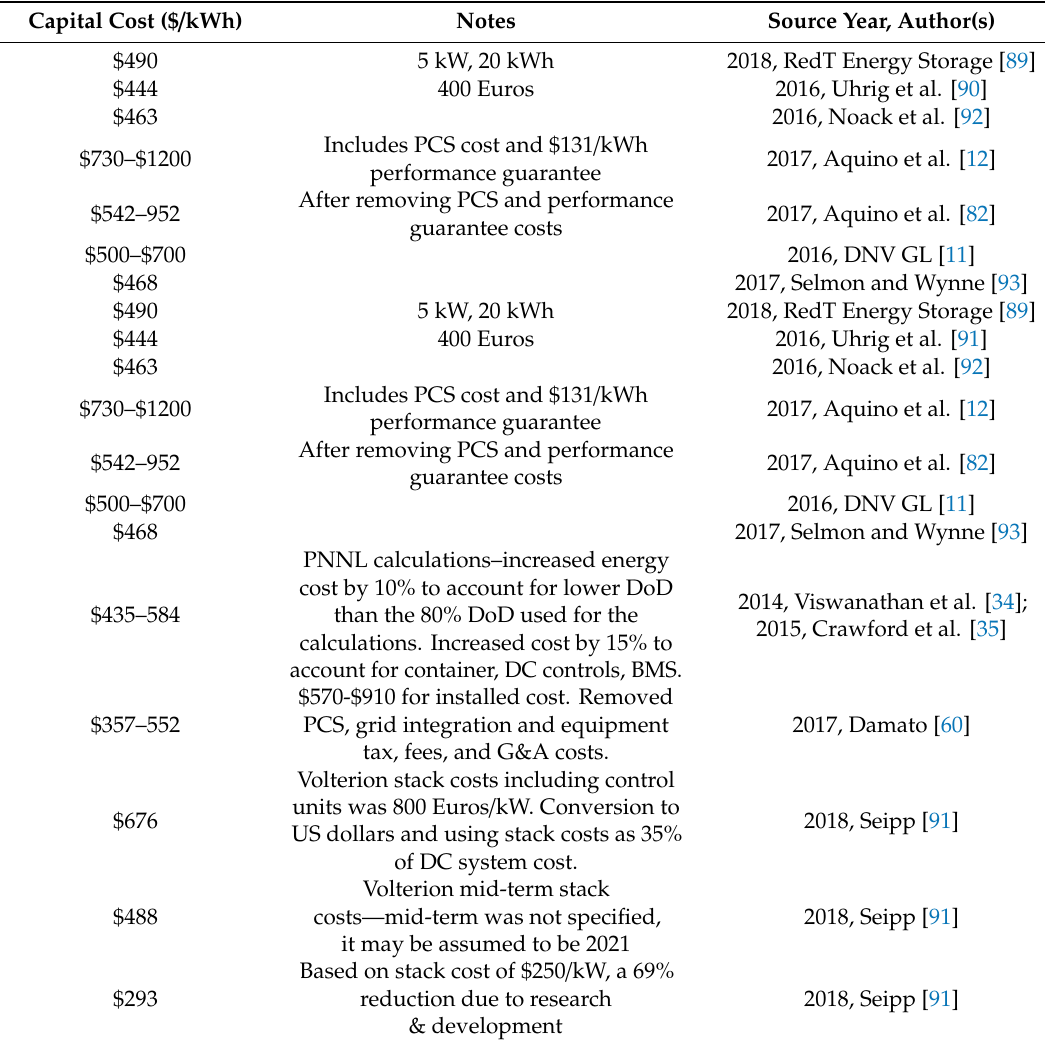
Table 17. Capital cost estimates—redox flow